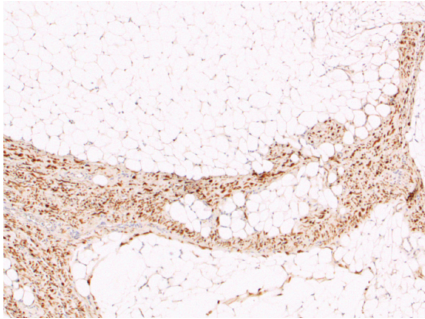
Figure 4: Immunohistochemistry. Picture showing immunoreac- tivity for desmin, a myogenic marker, in the nonfatty